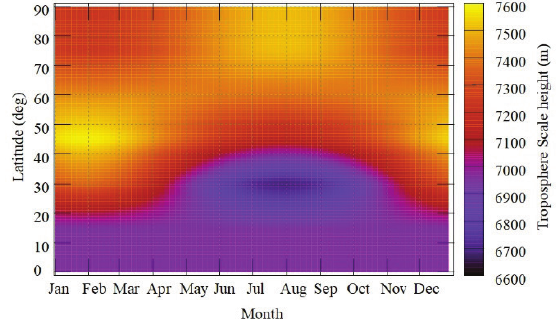
Figure 5. Simulation of the wet component of the troposphere scale height